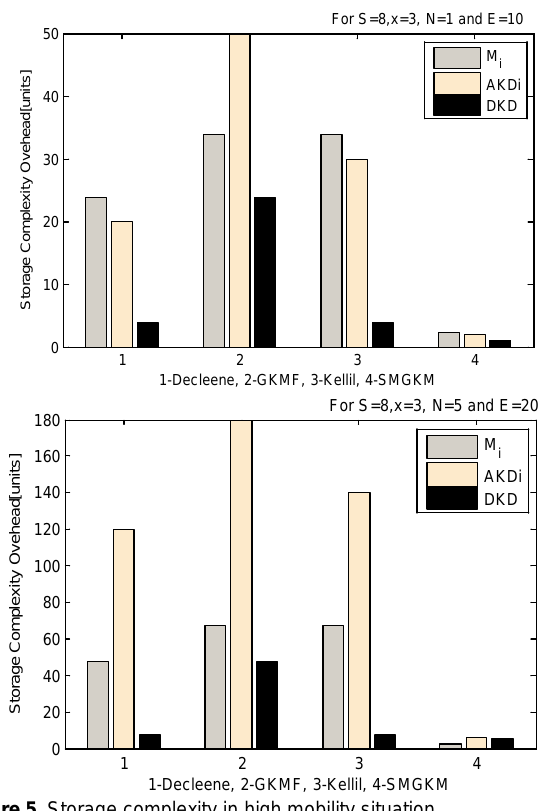
Figure 5. Storage complexity in high mobility